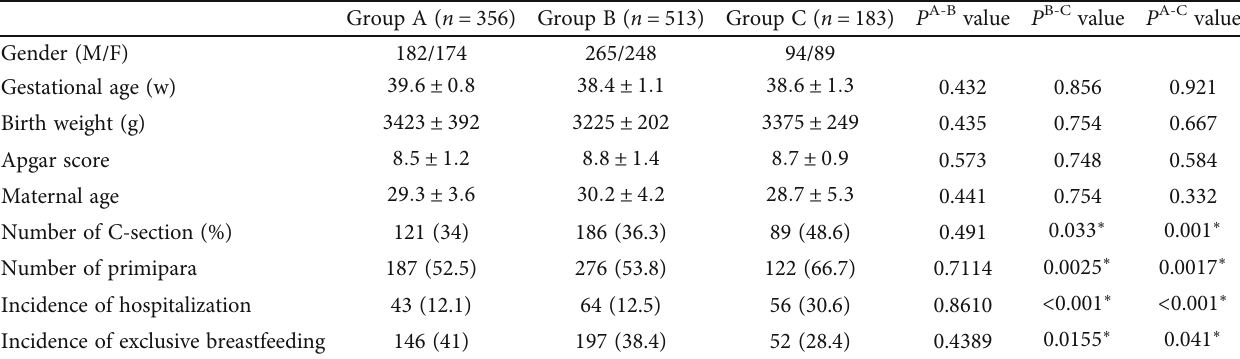
Figure 1: General characteristics of the selected groups. Table 1: Clinical characteristics and outcomes of the groups chosen.